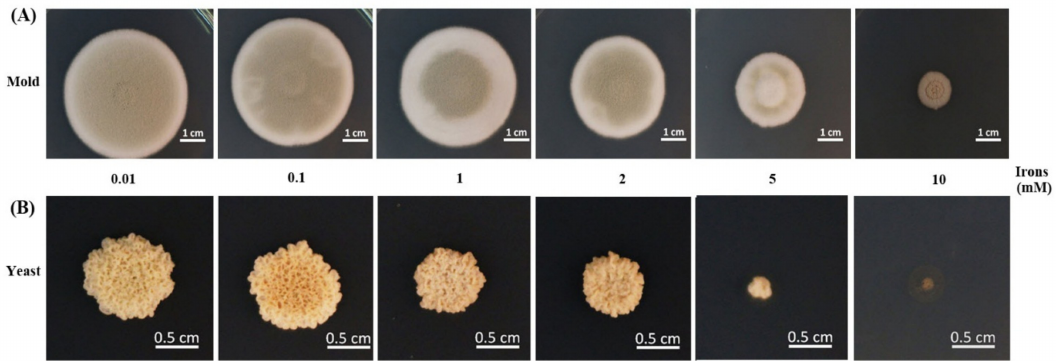
Figure 3. Growth of T. marne ff ei on solid media containing di ff erent iron concentrations. The 10 8 conidia of T. marne ff ei were spotted onto glucose minimal medium containing various concentrations of ferric chloride (0.01–10.00 mM). The cultured were incubated at either 25 ◦ C ( A , mold) or 37 ◦ C ( B , yeast) for 12